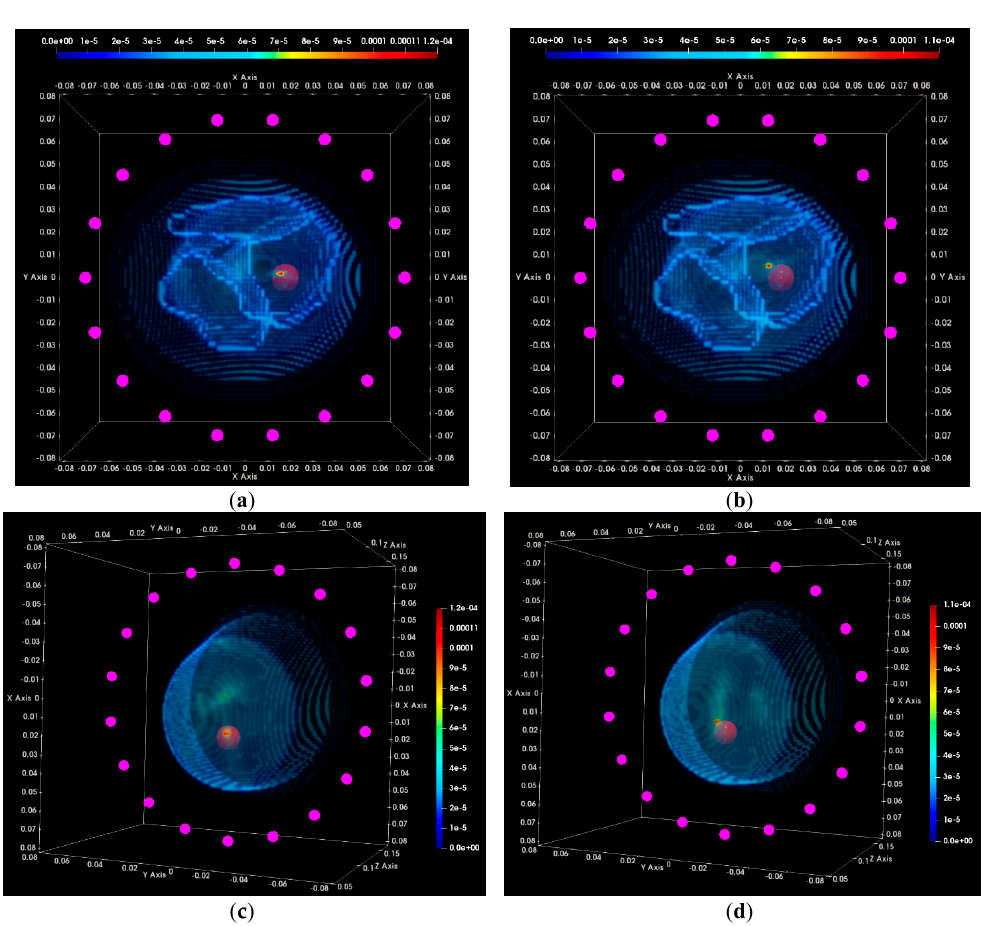
Figure 17. Breast rotational position #1—image in the interior of the breast only, formed at a single vertical position of the sensor network, in front of the tumor: ( a ) Test Date 1, top XY view, superposition of the fibroglandular and outer breast surface molds (blue color), red sphere indicating the tumor location; ( b ) Test Date 2, top XY view, superposition of the fibroglandular and outer breast surface molds (blue color), red sphere indicating the tumor location; ( c ) Test Date 1, 3D view, superposition of the outer breast surface mold (blue color), red sphere indicating the tumor location; ( d ) Test Date 2, 3D view, superposition of the outer breast surface mold (blue color), red sphere indicating the tumor location.